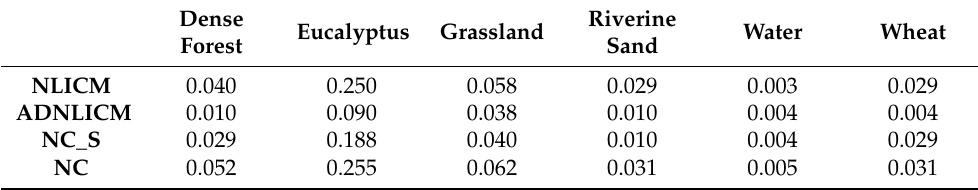
Table 10. Variance within the class for each algorithm for site 1 (Haridwar).